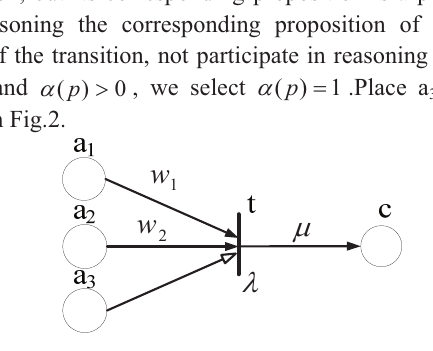
Fig.2 Improved AFPN graph of condition conjunctive rule The AFPN improved model has three fuzzy production